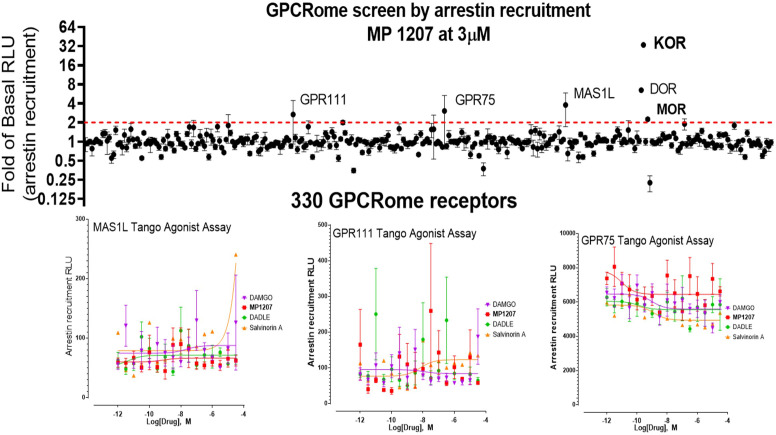
MP1207 is selective for opioid receptors in the GPCRome screen.MP1207 was screened against 330 non-olfactory GPCRs for agonism in the arrestin recruitment TANGO assay. Each point shows luminescence normalized to basal level at a given GPCR at 3 µM MP1207 dose (>3000 higher dose than the binding affinity at opioid receptors), with vertical lines indicating the standard error of the mean. MP1207 induces an increase in signal twofold over basal at opioid receptors predominantly at KOR and DOR and much less at MOR. Results show selectivity for opioid receptors over non-opioid targets when tested at >10µM and >1500 fold higher than the binding affinity and agonistic potency at opioid receptors. The low signal at MOR is consistent with null arrestin recruitment at MOR. Several potential targets (GPR111, MAS1L, GPR75) did not show dose-dependent increase in signal and probably represent screening false positives.